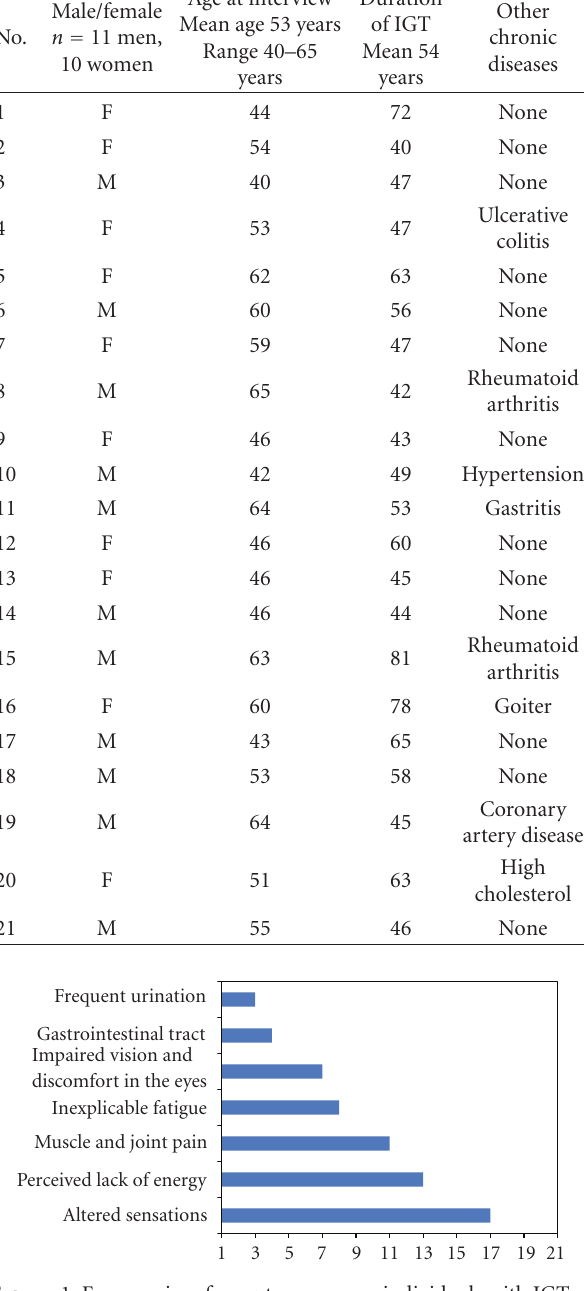
Figure 1: Frequencies of symptoms among individuals with IGT. Participants ( n = 21) could report more than one symptom.